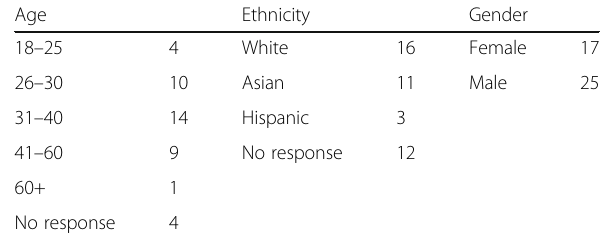
Table 4 Demographics of interviewees